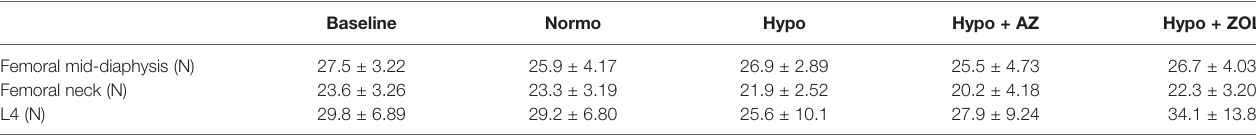
TABLE 4 | Maximum bone strength at femoral mid-diaphysis, femoral neck, and L4 of mice housed at normobaric ambient pressure (Normo) or hypobaric pressure (Hypo) at 500 mbar for four weeks and treated with acetazolamide (AZ) or zoledronate (ZOL).